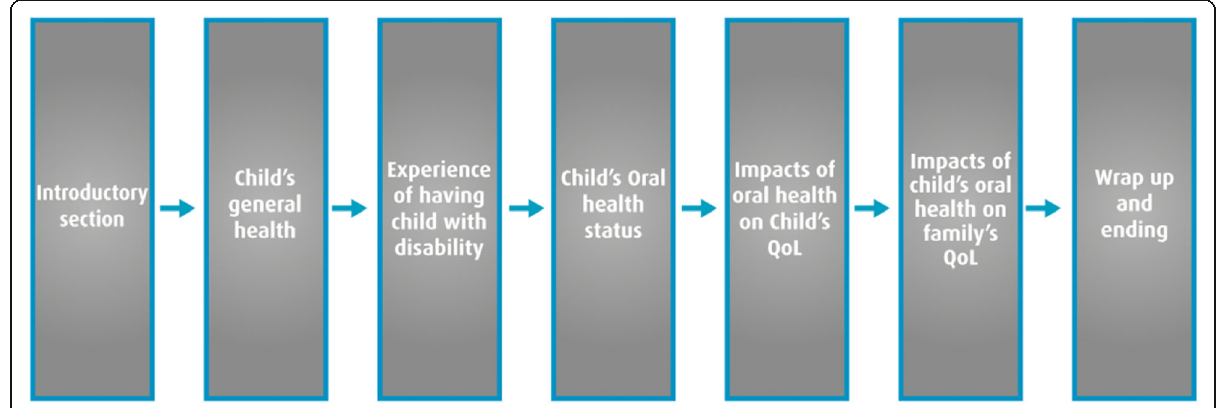
Fig. 2 Structure and Flow of the Topic